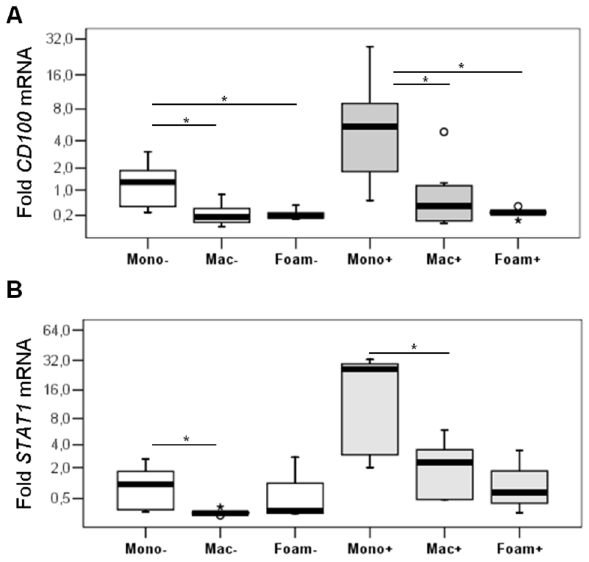
Figure 5. Resting and IFN-γ stimulated monocytes show increased levels of CD100 mRNA compared to macrophages and foam cells (A, B). Quantitative RT-PCR (qRT-PCR) for CD100 (A) or STAT-1 (B) in PB monocytes, macrophages and foam cells stimulated (+) or not (-) with IFN- γ. Folds relative to non stimulated monocytes (mono-), normalized with GAPDH. (a) * = significant p values (p≤0.05) in the comparisons in unstimulated and stimulated conditions.